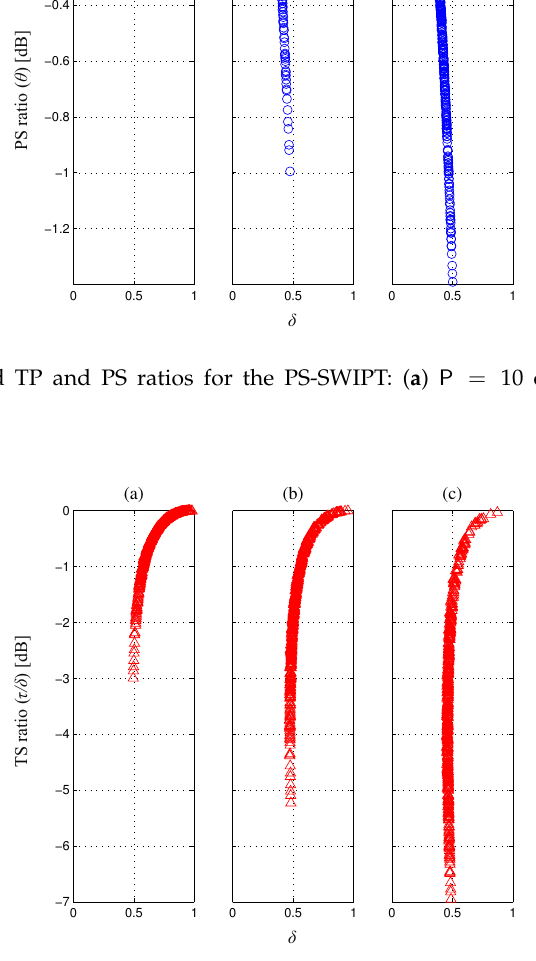
Figure 3. Optimized TP and TS ratios for the TS-SWIPT: ( a ) P = 10 dBm; ( b ) P = 20 dBm; ( c ) P = 30